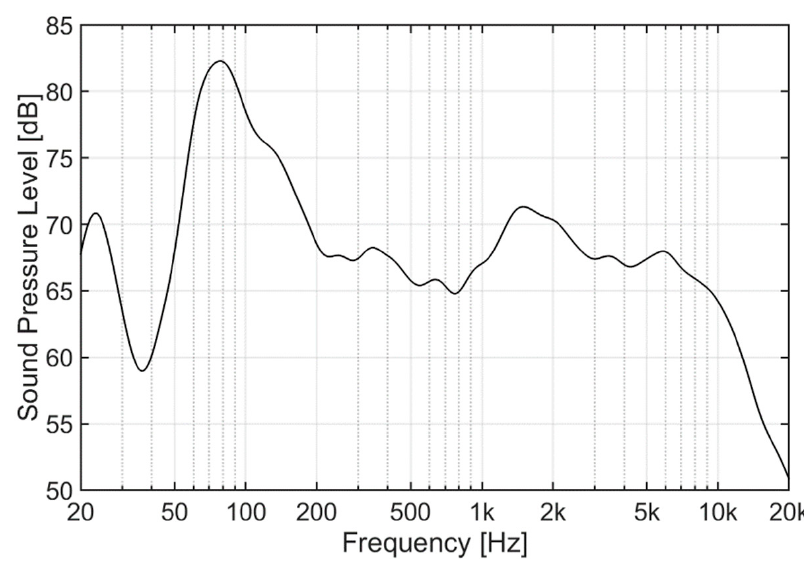
Figure 2. In-room response of the loudspeakers at the listening location.